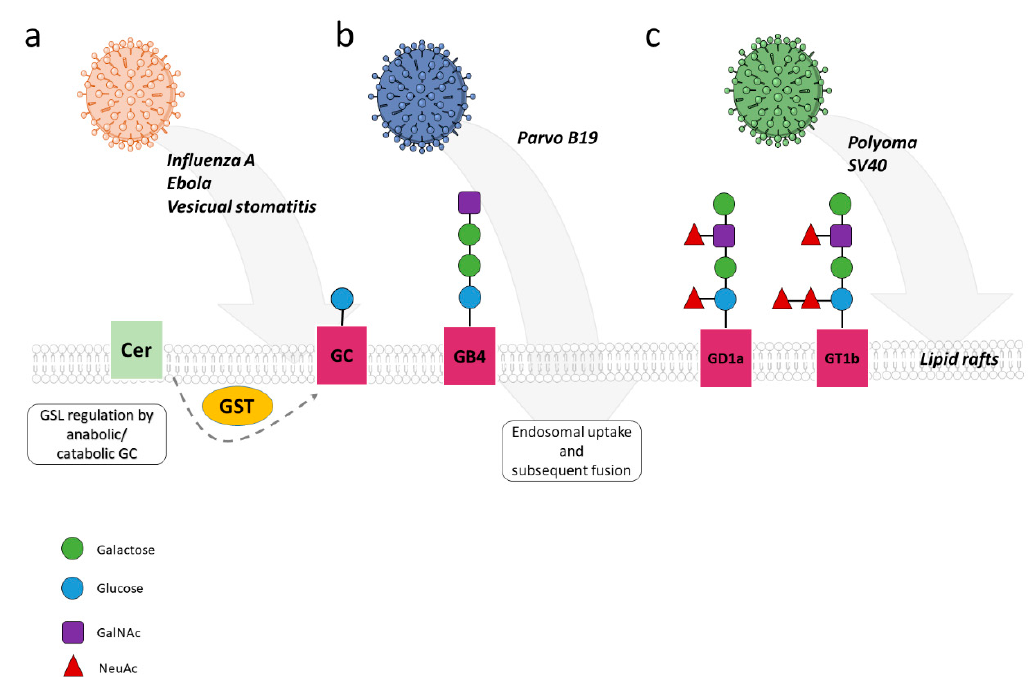
Figure 4. Influence of GSL on virus fusion and entry. Membrane domains enriched in glycosphingolipids (GSLs) are known to potentially directly support viral entry into host cells. ( a ) Glucosylceramide (GC) levels are particularly important for endosomal uptake of influenza A virus (IAV), Ebola, and vesicular stomatitis virus, whose uptake is sensitive to depletion of both anabolic and catabolic GC enzymes. ( b ) In addition, rearrangement of the viral parvovirus B19 capsid occurs through interaction with membrane-bound Gb4Cer (globo-tetraosyl-ceramide), which is required for subsequent steps of internalization in cells. ( c ) Gangliosides such as GD1a and GT1b or GM1 serve as important components in cell entry of murine polyomavirus and SV40. Notably, the interaction of SV40 VP1 with its cell surface ganglioside receptor GM1 is essential as a molecular trigger for SV40-induced vacuolization. Moreover, binding of gangliosides to 4-integrin promotes endocytosis and microtubular transport of polyoma virus capsids by initiating PI3K, FAK/Src, and MAPK pathways.